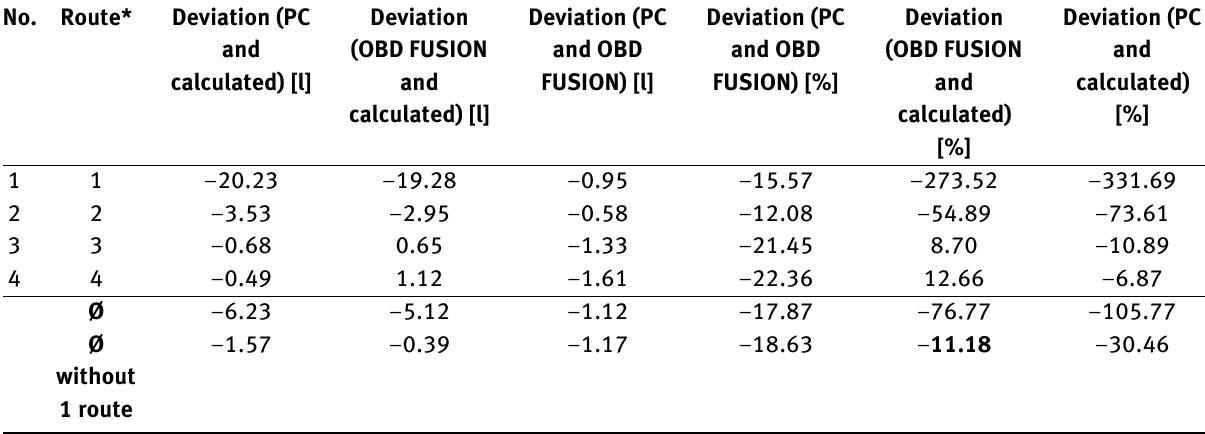
Table 9: Comparison of the second investigation deviation values in relation to fuel consumption of compression ignition engine No.